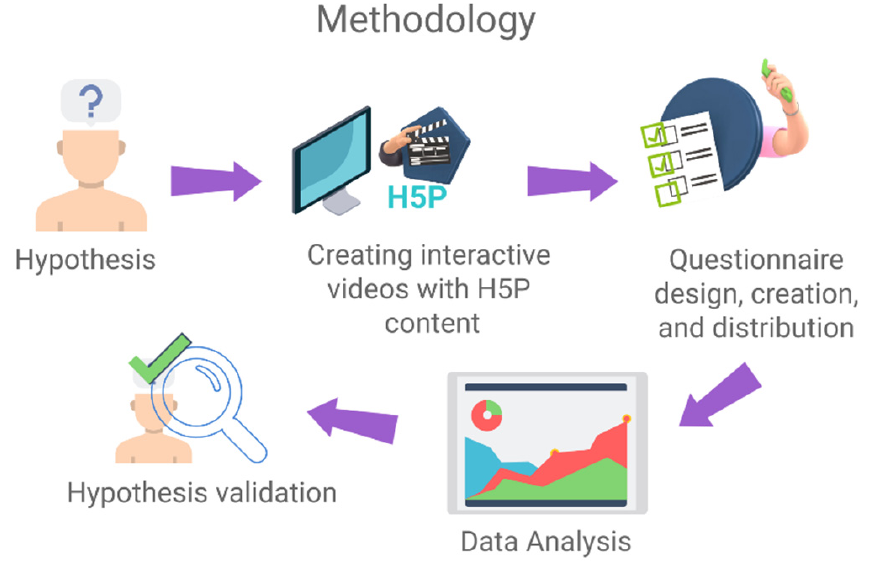
Figure 2. Methodology flow of the study.